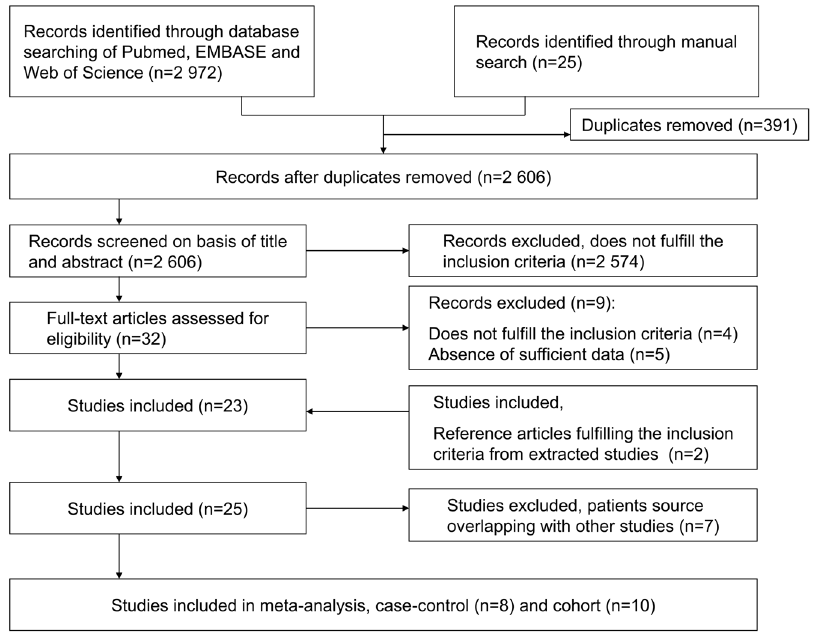
Figure 1. Flow diagram depicting the identification and selection of eligible case-control and cohort studies.